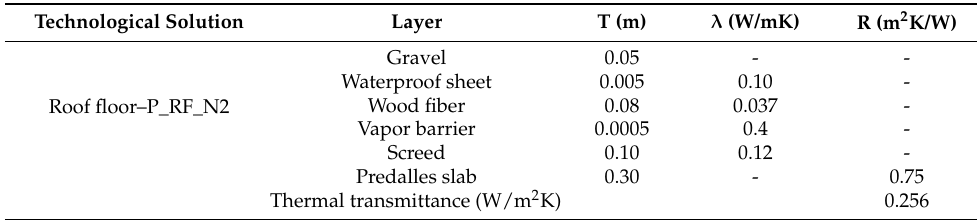
Table A13. Possible redevelopment measure for roof floor with gravel as the finishing layer (P_RF_N2).